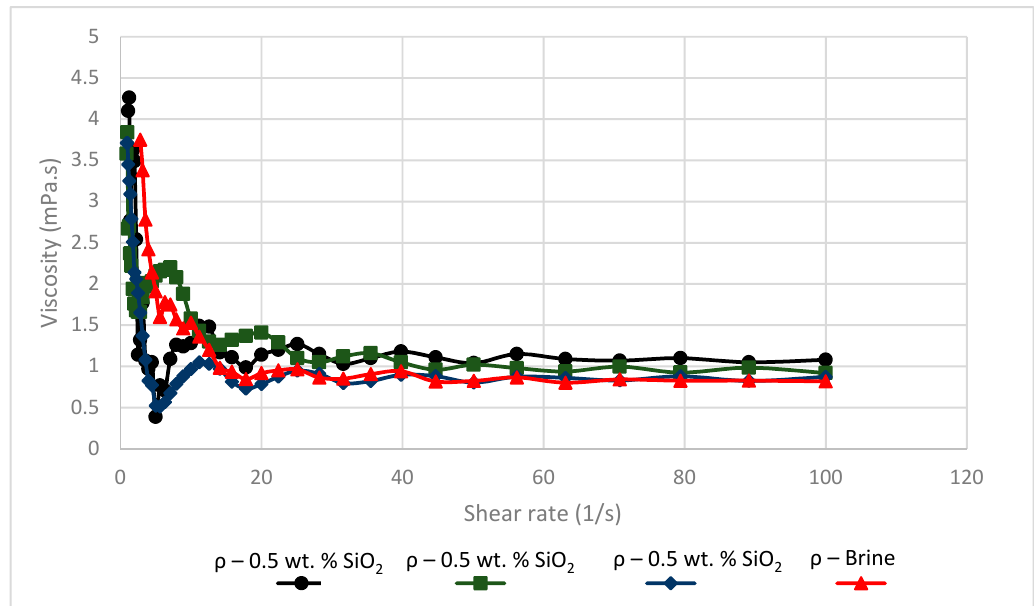
Figure 16. Viscosity against shear rate for brine and various SiO 2 nanofluid concentrations.